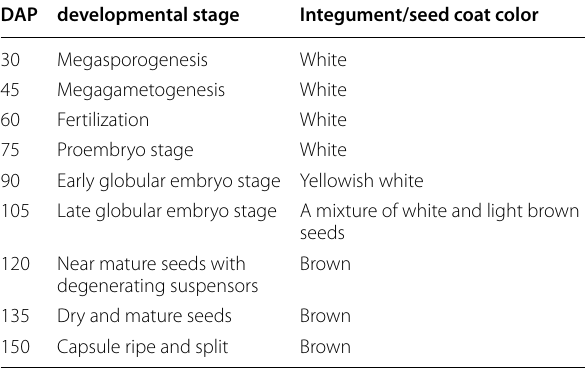
Table 1 Major microscopic structural events occurring in the developing pods of C. subtropicum after hand